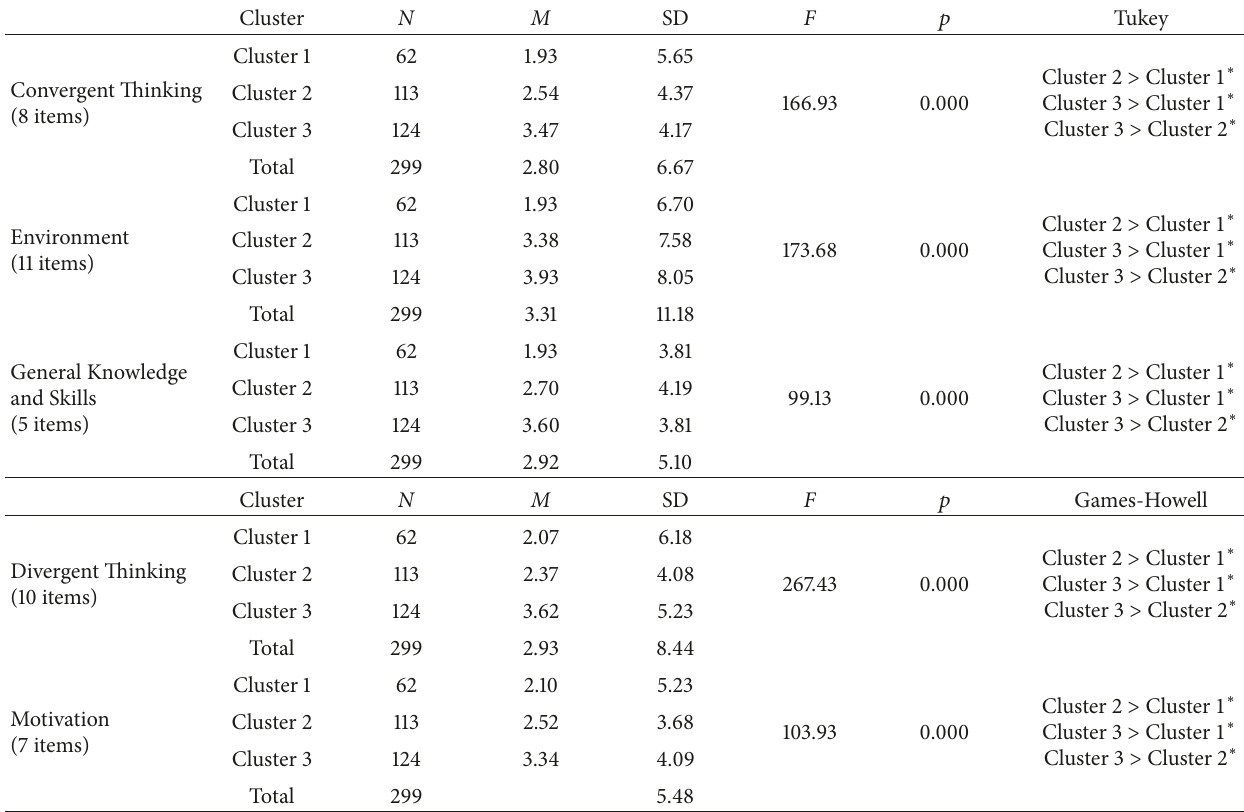
Table 4: One-way analysis of variance results for group differences in Convergent Thinking, Environment, General Knowledge and Skills, Divergent Thinking, and Motivation among the three attribute pattern